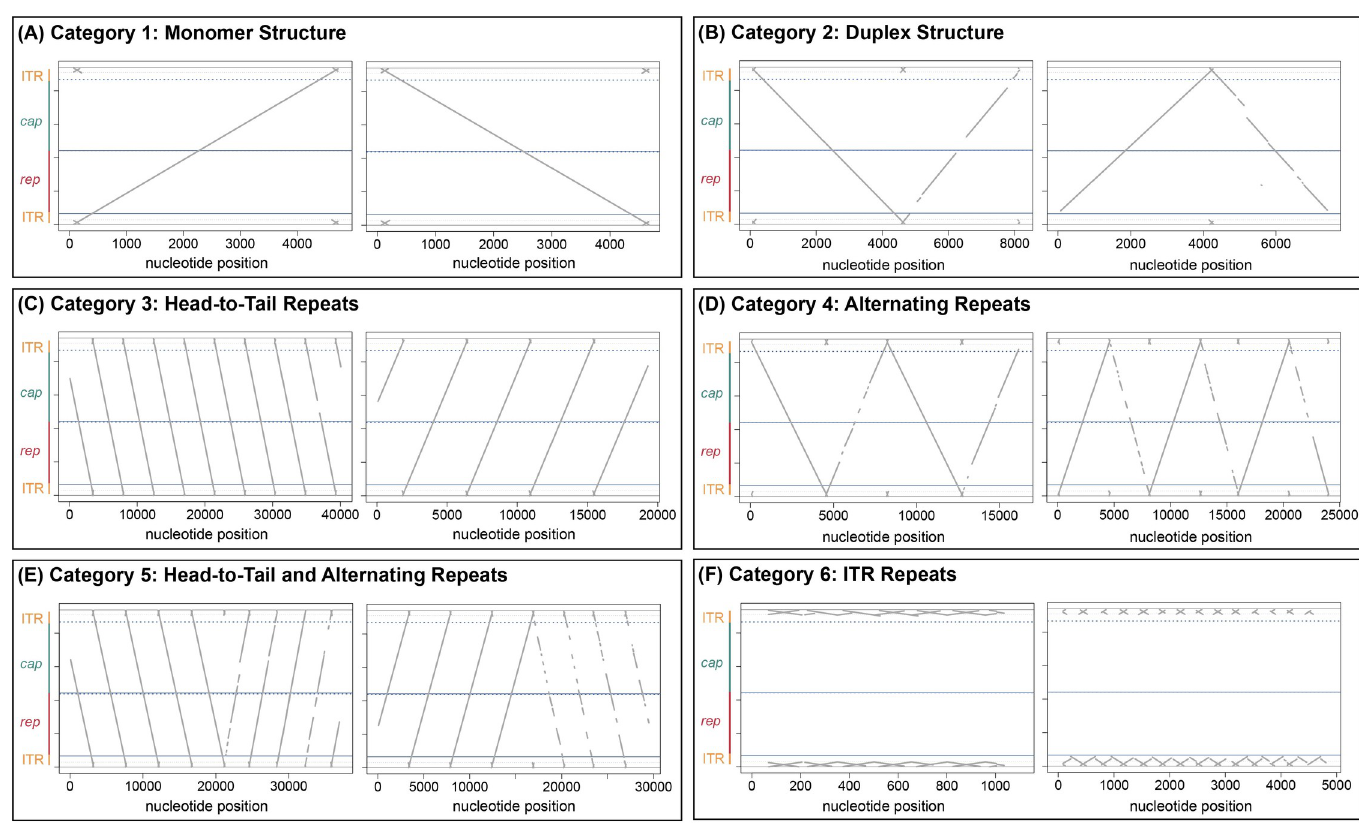
Fig 2. AAV2 replication intermediates. (A-F) Dot plots of two representative individual reads per category from AAV2/HSV-1 co-infected BJ cells are shown. Extrachromosomal DNA was isolated at 12 hpi from BJ cells infected with AAV2 (gcp/ cell = 20’000) and HSV-1 (pfu/cell = 1).